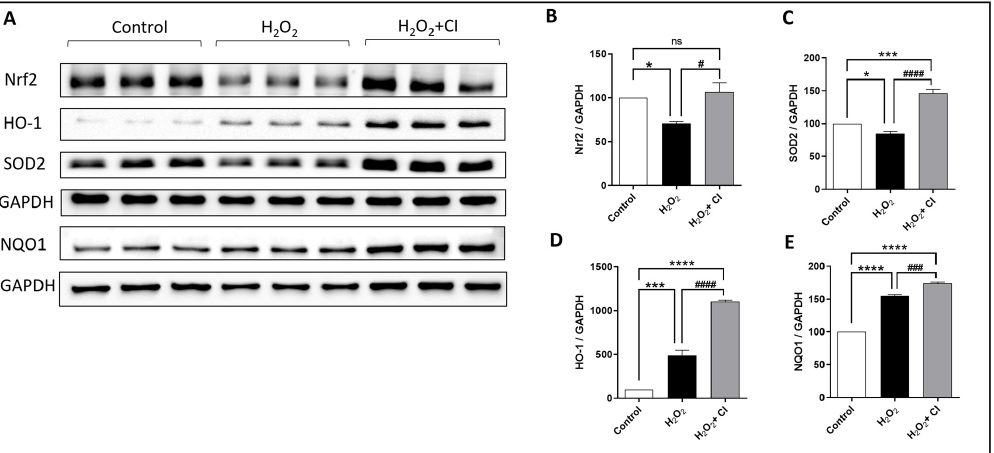
Figure 6. The effect of CI on the H 2 O 2 -induced oxidative stress in SH-SY5Y cells. SH-SY5Y cells were treated with 200 μ M H 2 O 2 with or without 10 μ M CI for 5 h, then after the cell culture medium was replaced with a fresh one with or without 10 μ M CI for another 24 h. ( A ) WB of different oxidative stress and antioxidant-related proteins in the Sh-SY5Y cell lysate was assessed. H 2 O 2 significantly reduces the expression of Nrf2 ( B ) and SOD2 ( C ) and increases the expression of HO-1 ( D ) and NQO1 ( E ) compared to the unstimulated control group. However, in CI treatment groups, the levels of Nrf2, SOD2, HO-1, and NQO1 were significantly increased as compared to the H 2 O 2 group. Data are expressed as mean ± SEM of three independent experiments where p < 0.05 was considered significant. * p < 0.05, *** p < 0.001, **** p < 0.0001 relative to control group. # p < 0.05, ### p < 0.001, #### p < 0.0001 relative to H 2 O 2 group. (See Figure S5 for original Western blot images.)